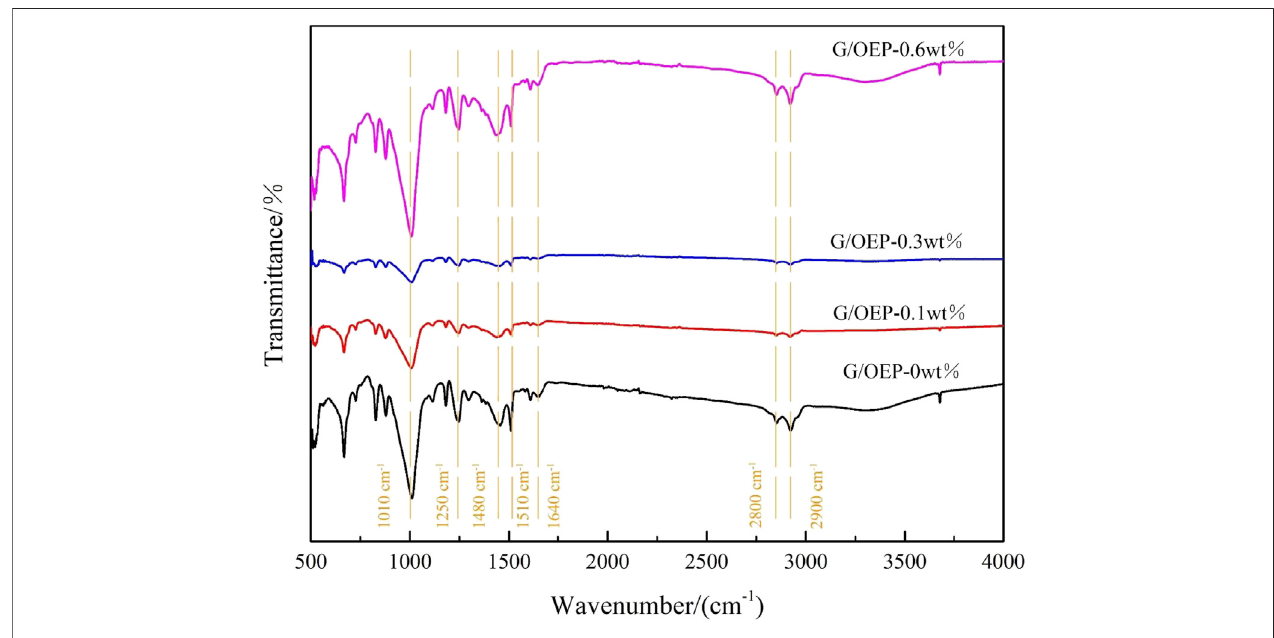
FIGURE 3 | Graphene FI-TR test spectrum.